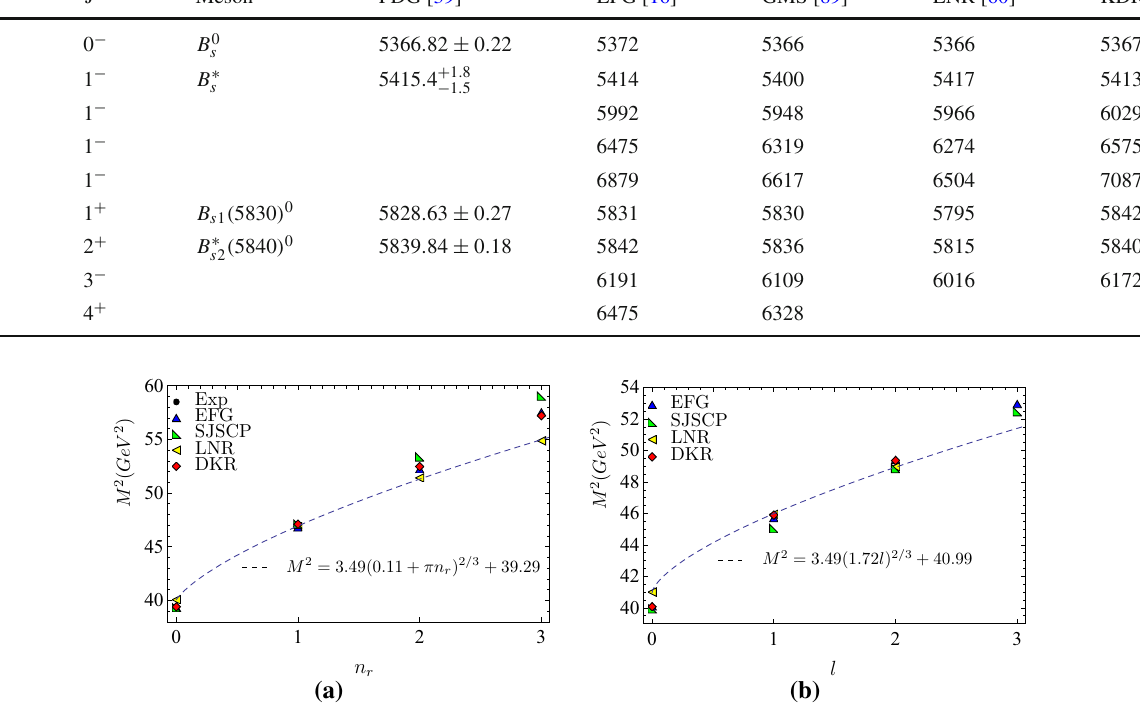
Fig. 7 (Color online) The radial and orbital Regge trajectories for the bottom-charmedmesons.ThetheoreticaldataarefromRef.[90](EFG), [91](SJSCP),[92](DKR)and[79](LNR).Theexperimentaldata(Exp)